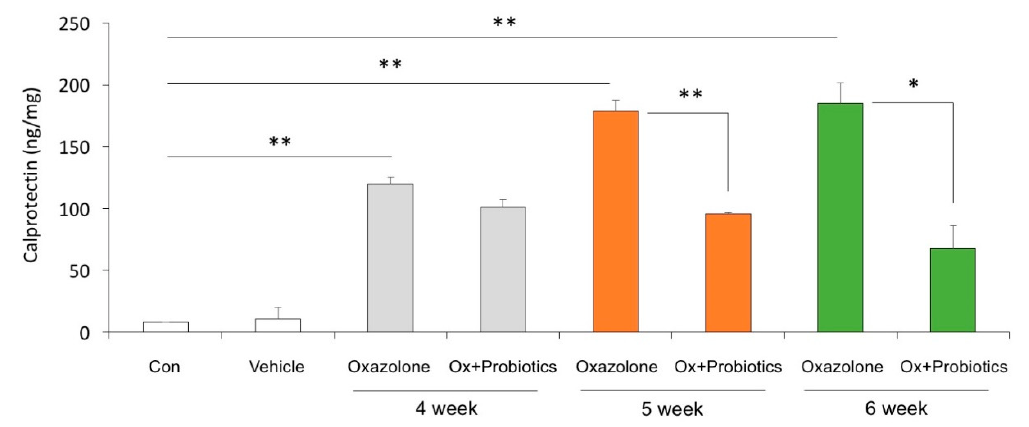
Figure 5. E ff ects of probiotics on calprotectin levels in Ox-induced AD. The levels of fecal calprotectin in stool samples of the Con, Ox, and Ox + Probiotics groups. The concentrations of calprotectin were measured by ELISA. The stool samples were collected once a week for 3 weeks after the administration of probiotics. Data pooled from two independent experiments are presented as the mean ± SD. * p < 0.05, ** p <